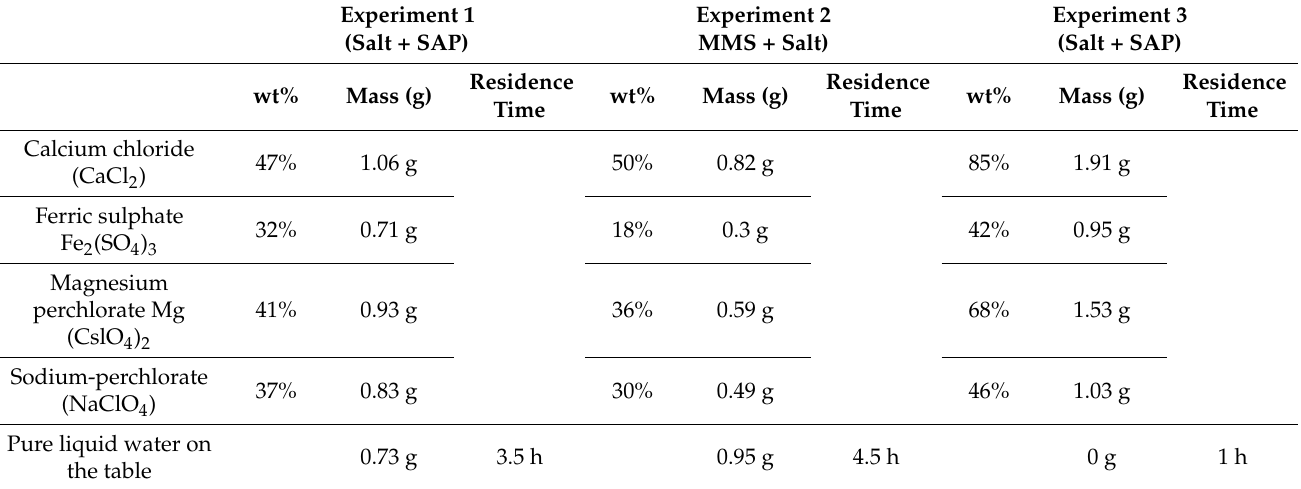
Table 1. Results of the simulations of the water-cycle interaction between the atmosphere and the ground under Martian conditions. Summary of the amount of water captured as weight total percentage (wt%) (mass increase/total weight) in the product, the final increase in mass of water and, for the case of formation of pure liquid water, the residence time, i.e., time of observation of water as liquid beyond the point of